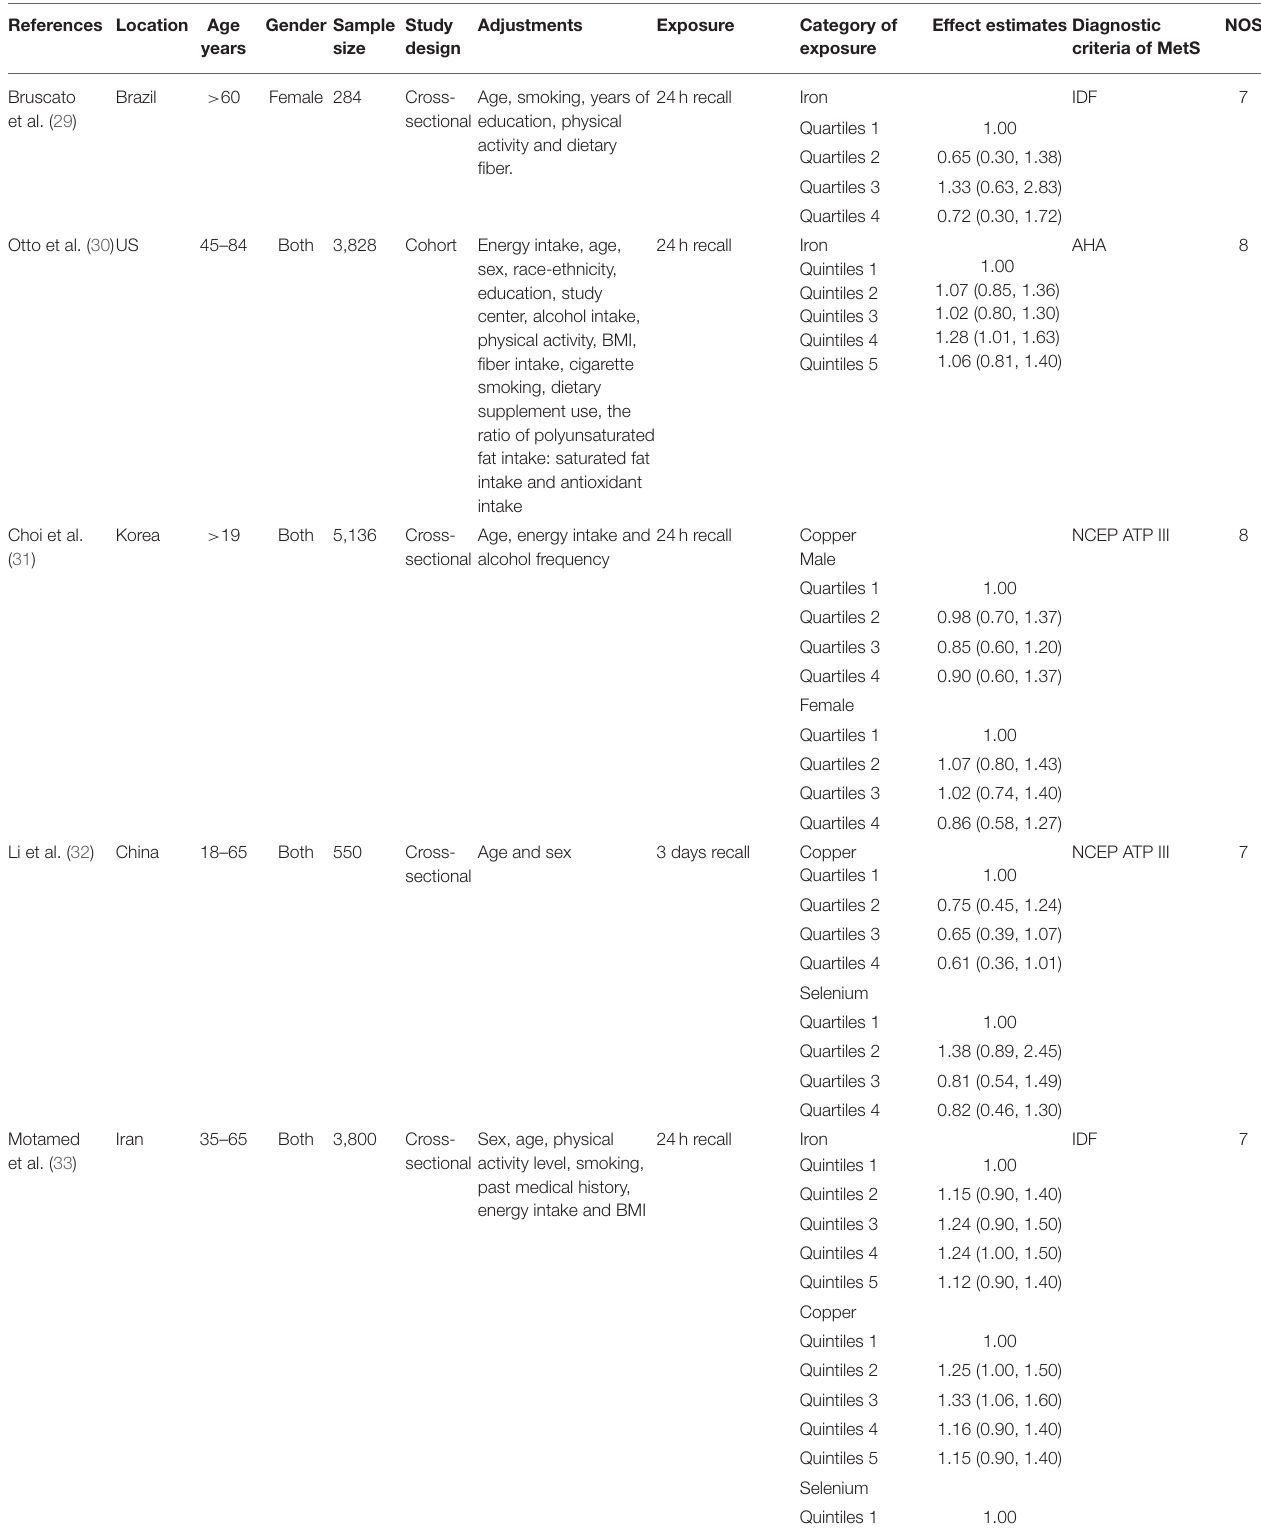
TABLE 1 | Characteristics of the individual studies included in this